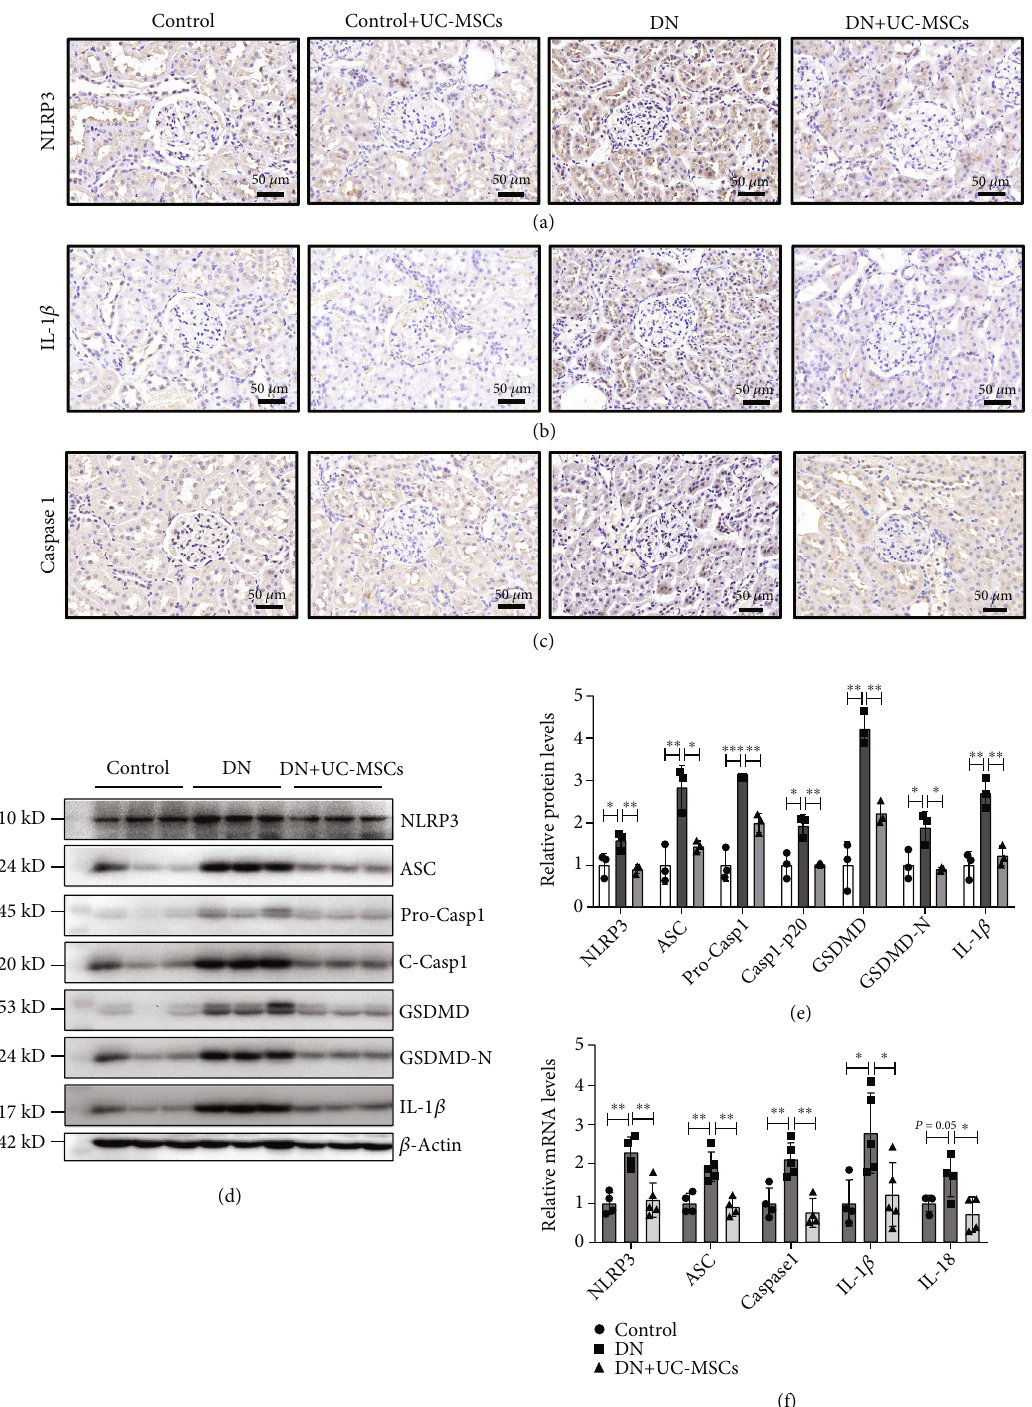
Figure 4: UC-MSCs inhibit renal pyroptosis through the NLRP3/Caspase1 signaling pathway in vivo . (a – c) Representative graphs of kidney sections with immunohistochemistry staining for NLRP3, Caspase1, and IL-1 β . Scale bar, 50 μ m. (d, e) The protein levels of NLRP3, ASC, Caspase1, GSDMD, and IL-1 β were measured by western blot in the control, DN, and DN+UC-MSC groups. (f) RT-PCR analysis of NLRP3, ASC, Caspase1, IL-1 β , and IL-18 mRNA expressions in the control, DN, and DN+UC-MSC groups. Data are expressed as means ± SD . ANOVA was used for comparison among multiple groups. ∗ p < 0 : 05 and ∗∗ p < 0 : 01